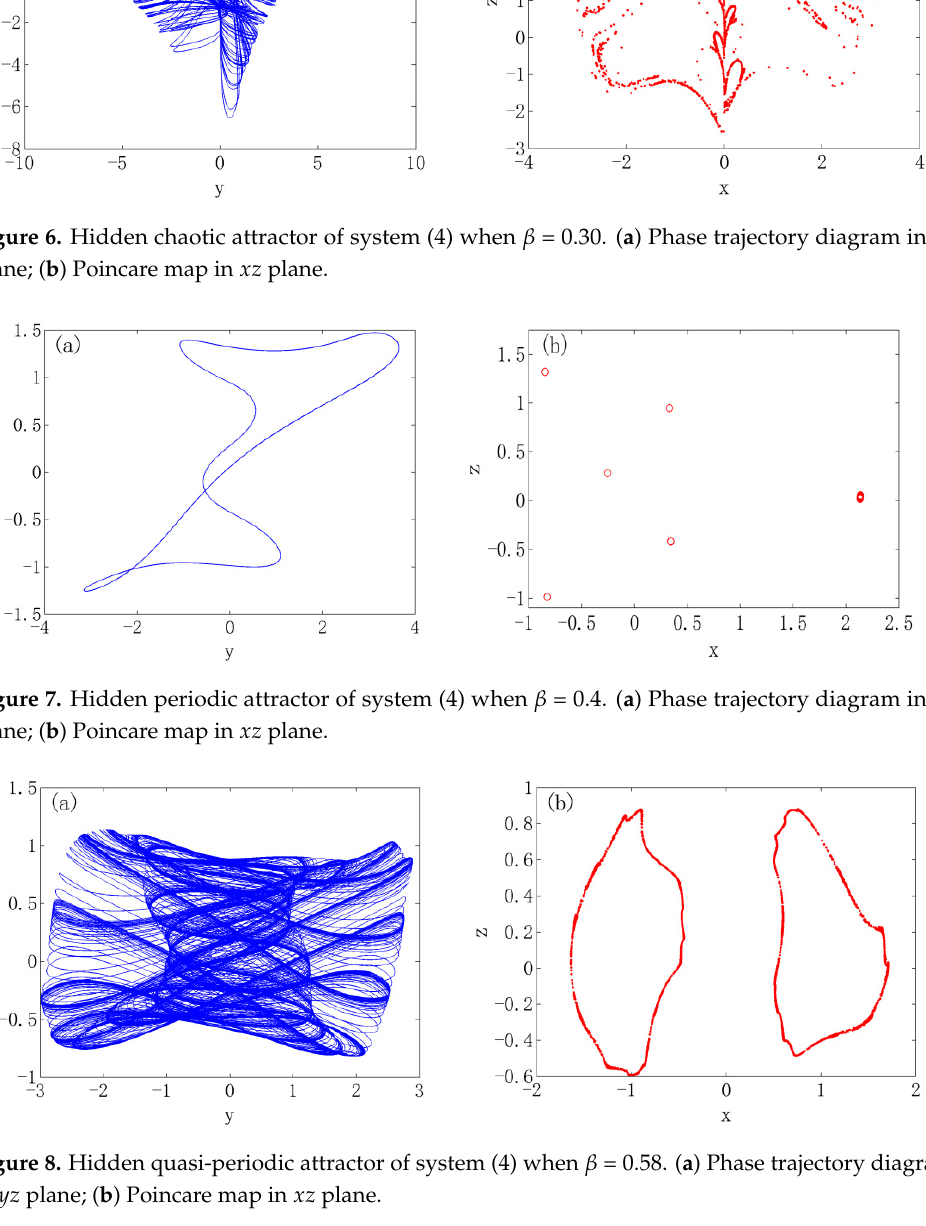
Figure 9. Bifurcation diagram of (cid:1876) in system (4) with change of (cid:2010) from 0.1 to 0.8. Figure 10. Lyapunov exponents in system (4) when (cid:2010) = 0.3. 3.2. Coexistence of Different Hidden Attractors When system parameters and the order are all taken as fixed constants, the proposed system (4) can exhibit various hidden attractors according to different initial values, which means that the coexistence of different hidden attractors can be found in fraction- al-order system (4) (see Figures 11 and 12). Figure 11 depicts the phase trajectory and the Poincare map of the coexistences of hidden chaotic attractors in system (4) when 0.28 α= , (cid:2010) = 0.8 . Phase trajectory and the Poincare map of the coexistences of the hidden chaotic attractor and 2D torus are shown in Figure 12, where α = 0.95, (cid:2010) = 0.58 . In all simulations, the other values of parameters are chosen as above.